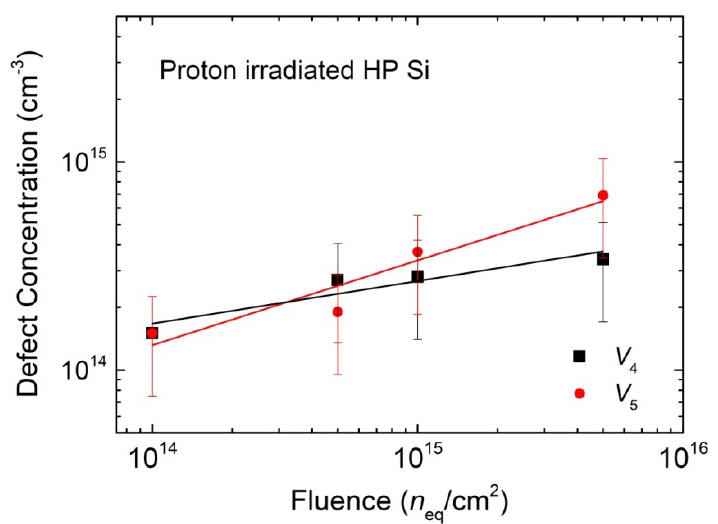
Figure 8. The concentrations of V 4 and V 5 formed under the irradiations of HPSi samples with 23-MeV protons as a function of the fluence rising from 1 × 10 14 to 5 × 10 15 n eq /cm 2 . The solid lines, fitted to the experimental data by linear regression, are the trend lines showing the character of the [ V 4 ] and [ V 5 ] changes with the fluence.